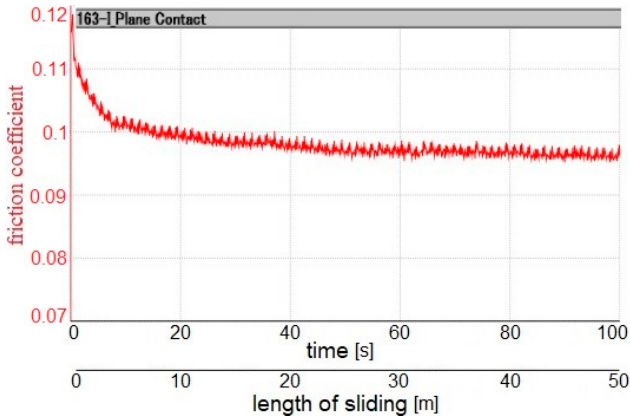
Figure 8. Dependence of the friction coefficient on the length of sliding for the 163-I sample surface.